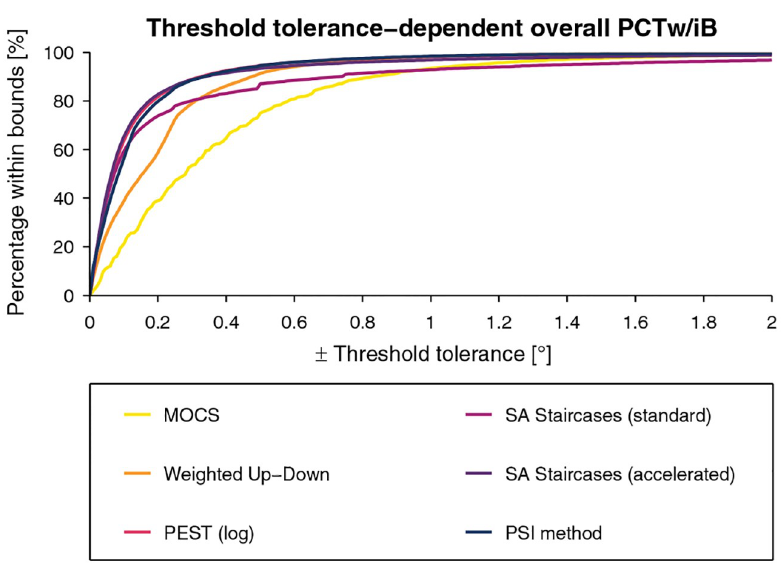
Fig 12. Overall percentage within bounds for the threshold estimates. Overall percentage within bounds ( PCTw/iB ) function for threshold estimation for a linearly resampled parameter space.